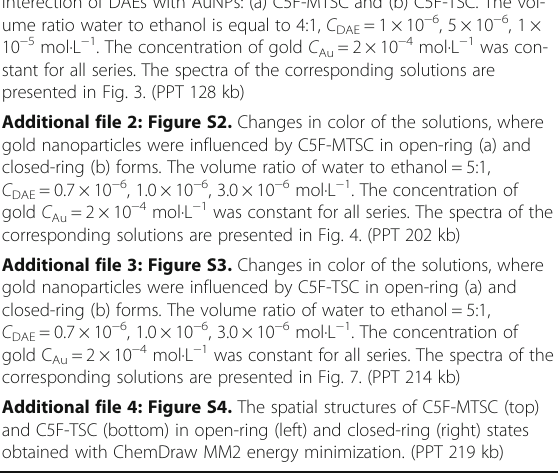
Additional file 1: Figure S1. The color changes that represents the interection of DAEs with AuNPs: (a) C5F-MTSC and (b) C5F-TSC. The vol- ume ratio water to ethanol is equal to 4:1, C DAE = 1× 10 − 6 , 5× 10 − 6 , 1 × 10 − 5 mol·L − 1 . The concentration of gold C Au = 2× 10 − 4 mol·L − 1 was con- stant for all series. The spectra of the corresponding solutions are presented in Fig. 3. (PPT 128 kb) Additional file 2: Figure S2. Changes in color of the solutions, where gold nanoparticles were influenced by C5F-MTSC in open-ring (a) and closed-ring (b) forms. The volume ratio of water to ethanol = 5:1, C DAE = 0.7× 10 − 6 , 1.0× 10 − 6 , 3.0× 10 − 6 mol·L − 1 . The concentration of gold C Au = 2 × 10 − 4 mol·L − 1 was constant for all series. The spectra of the corresponding solutions are presented in Fig. 4. (PPT 202 kb) Additional file 3: Figure S3. Changes in color of the solutions, where gold nanoparticles were influenced by C5F-TSC in open-ring (a) and closed-ring (b) forms. The volume ratio of water to ethanol = 5:1, C DAE = 0.7× 10 − 6 , 1.0× 10 − 6 , 3.0× 10 − 6 mol·L − 1 . The concentration of gold C Au =2 × 10 − 4 mol·L − 1 was constant for all series. The spectra of the corresponding solutions are presented in Fig. 7. (PPT 214 kb) Additional file 4: Figure S4. The spatial structures of C5F-MTSC (top) and C5F-TSC (bottom) in open-ring (left) and closed-ring (right) states obtained with ChemDraw MM2 energy minimization. (PPT 219